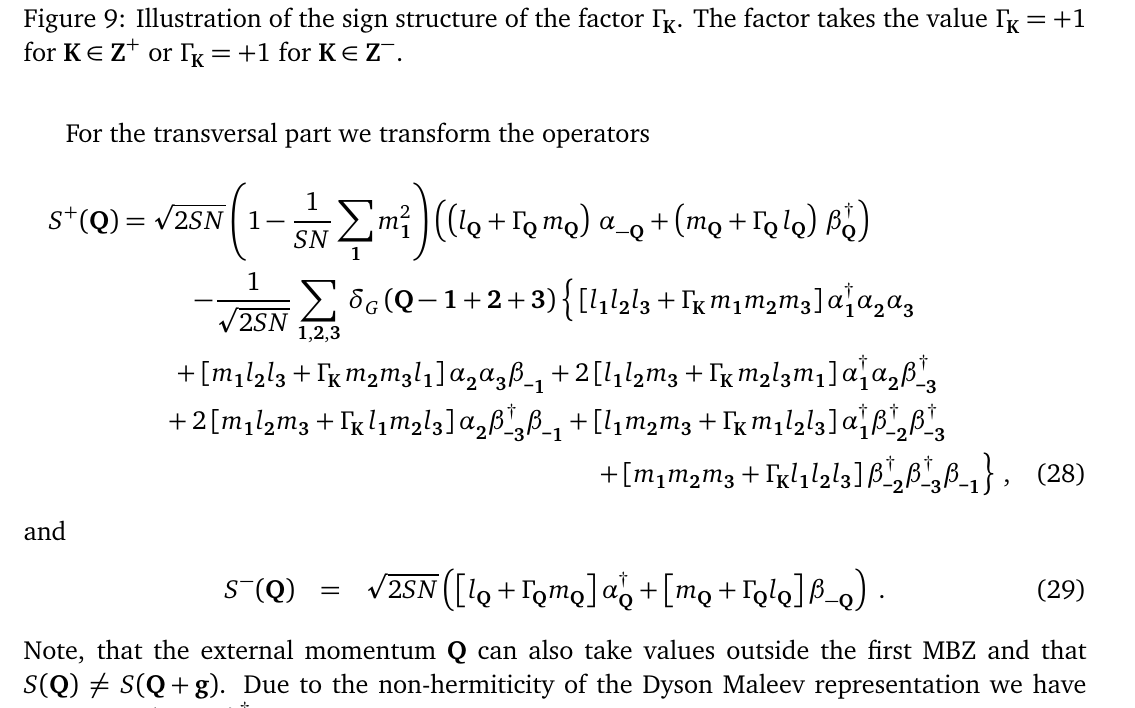
. The factor takes the value Γ K